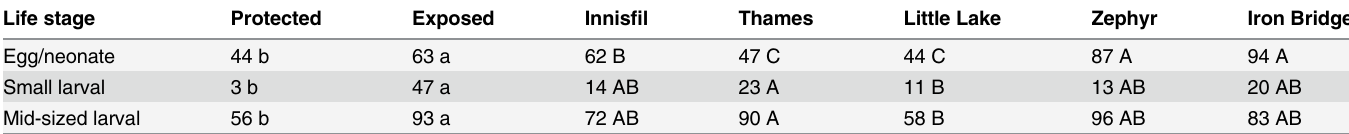
Table 5. Differences in apparent mortality (%) among life tables of Sirex developing in Pinus sylvestris by treatment for experimentally-manipu- lated cohorts and separately by site for natural cohorts. Life stage Protected Exposed Innis fi l Thames Little Lake Zephyr Iron Bridge Egg/neonate 44 b Small larval Mid-sized larval Each life stage was tested separately using a generalized linear model. Different letters indicate statistically signi fi cant differences ( P < 0.05) among cohorts according to Tukey ’ s HSD. Lowercase letters indicate differences between experimentally-manipulated cohorts, and uppercase letters indicate differences among natural cohorts